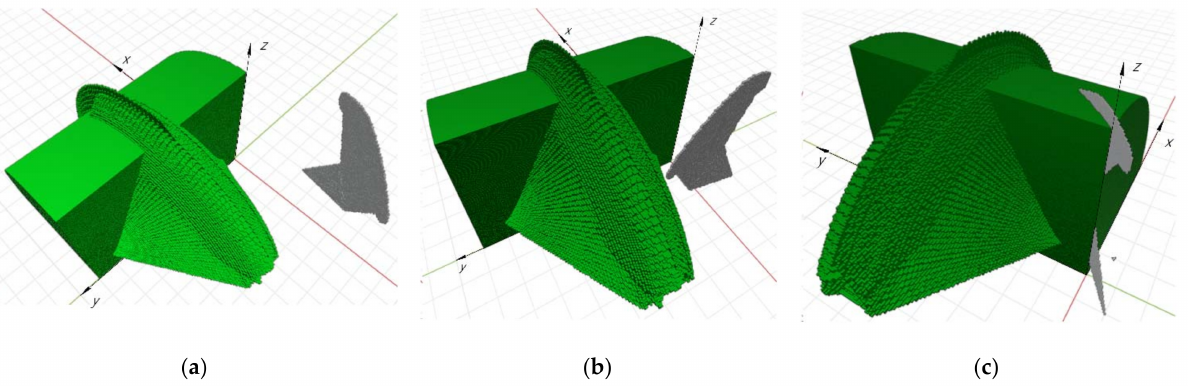
Figure 13. Relative position of technological areas of manipulators—( a ) absence of intersections, ( b ) presence of collisions of links without intersection of technological areas, ( c ) presence of